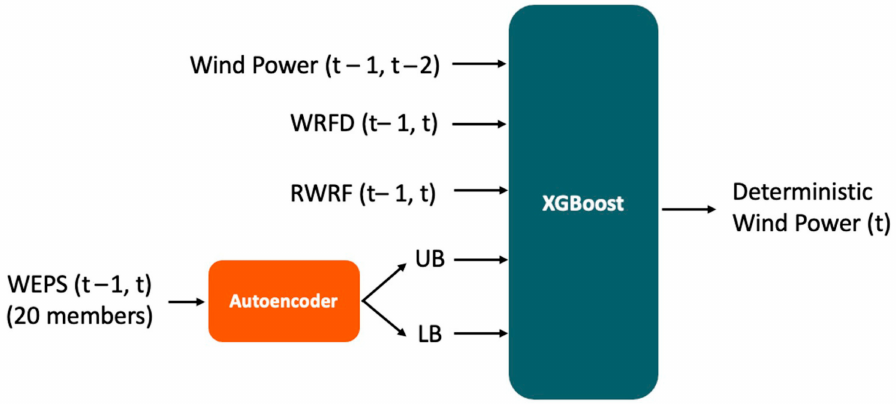
Figure 9. Proposed three-hour-ahead deterministic forecasting